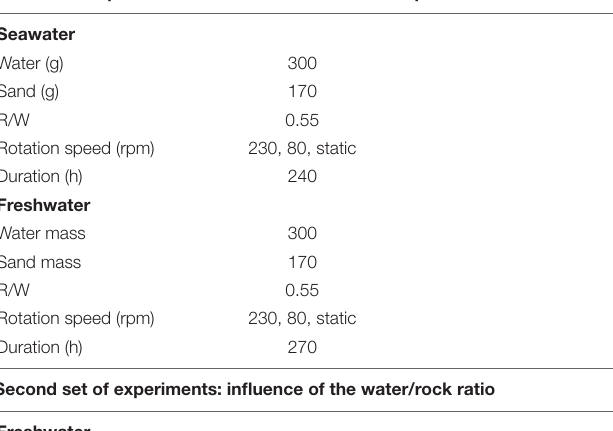
TABLE 1 | Recap chart of the experimental